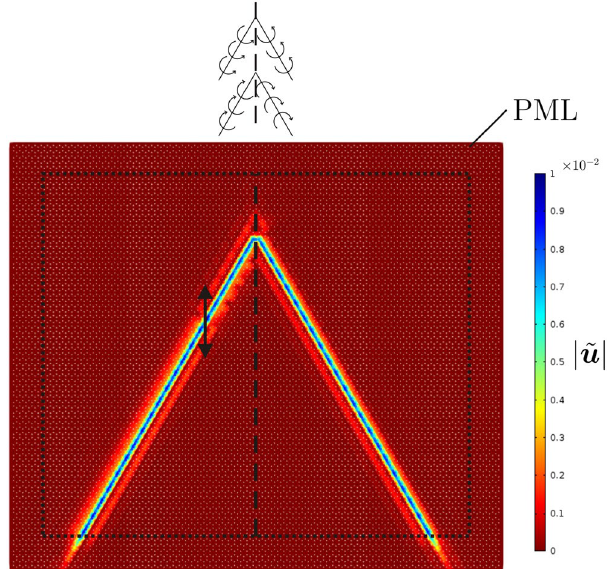
Figure 1. Deviation of a unidirectionally localised wave (“elastic prism”) in an elastic gyro-system. Each macro- cell contains two spinners rotating in opposite directions, as shown in Fig. 2b. The unidirectionally localised wave is generated by a harmonic displacement of amplitude 0.01, indicated by the arrow. The amplitude of the total normalised displacement, defined in the next sections, is plotted in the